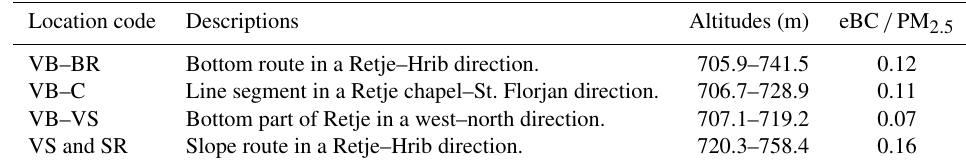
Table 5. List and description of the different route segments along the Retje hollow.